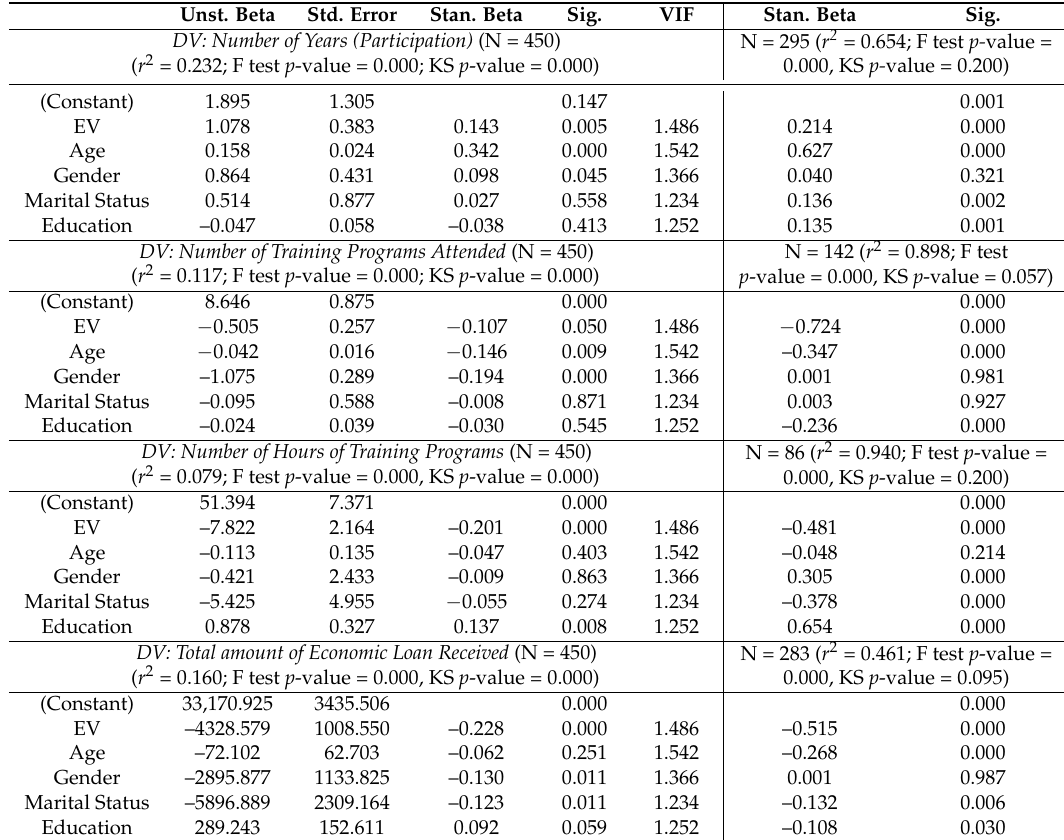
Table 5. The regression